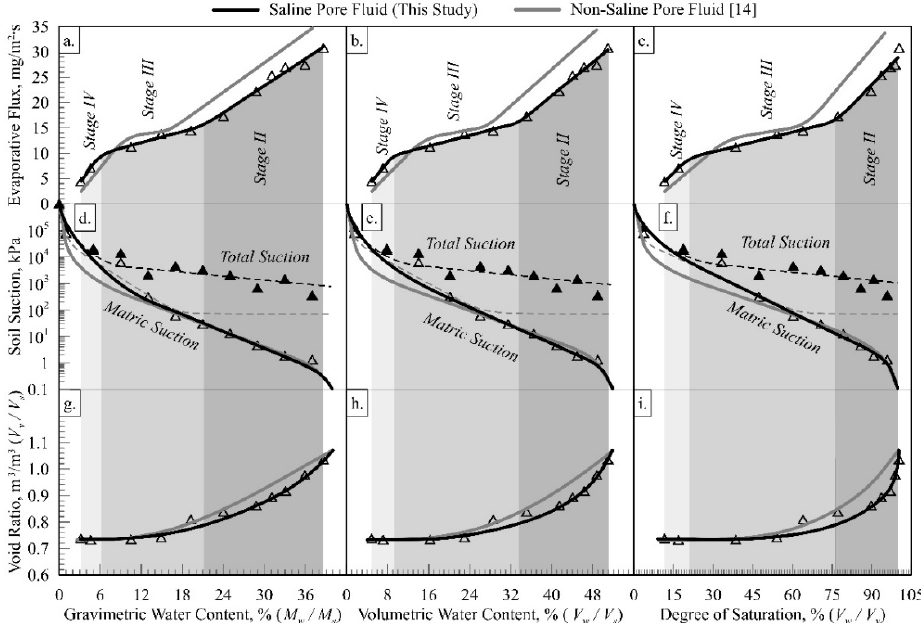
Figure 4. Behavior of lean clay under low atmospheric demand: ( a ) w -based evaporative flux; ( b ) θ -based evaporative flux; ( c ) S -based evaporative flux; ( d ) w -based water retention curve; ( e ) θ -based water retention curve; ( f ) S -based water retention curve; ( g ) w -based soil shrinkage curve; ( h ) θ -based soil shrinkage curve; and ( i ) S -based soil shrinkage curve.